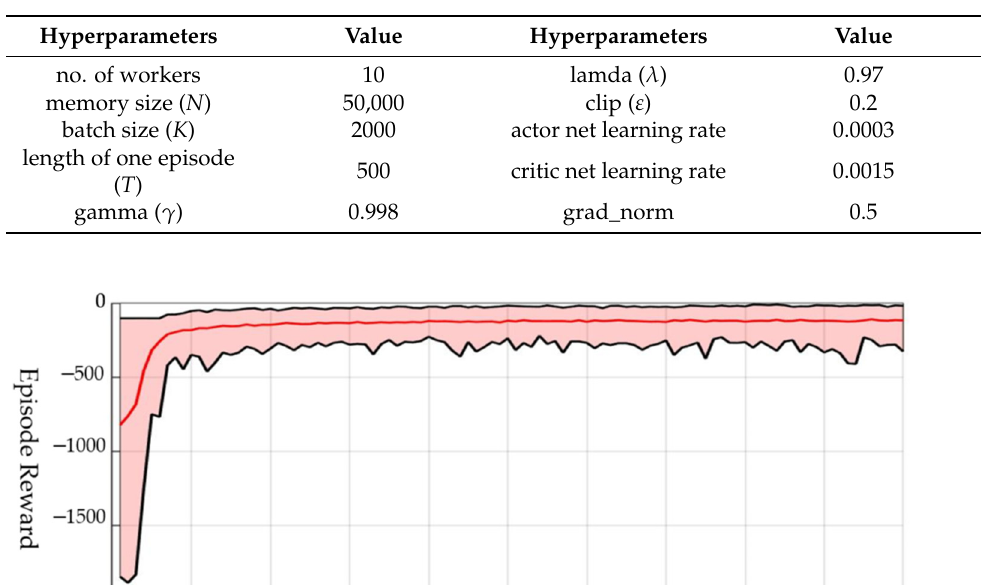
Table 1. List of hyperparameters for Batch-PPO algorithm.